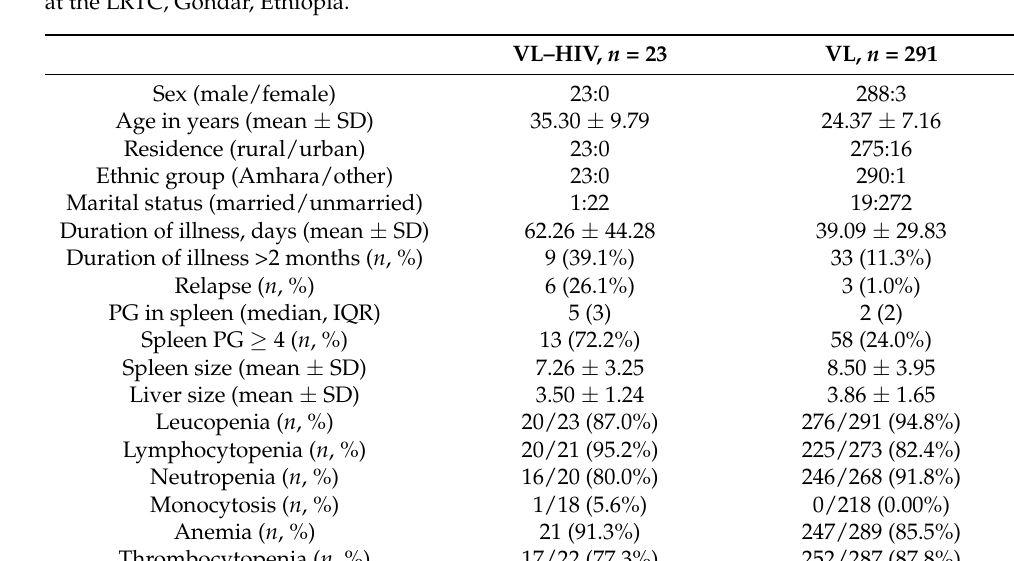
Table 1. Subject characteristics and clinical data among VL patients with and without HIV coinfec ‐ tion at the LRTC, Gondar, Ethiopia.